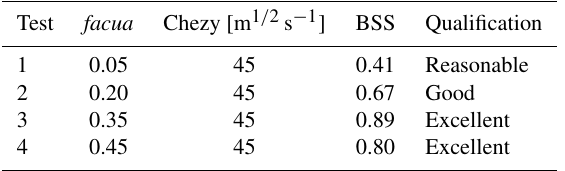
Table 4. XBeach morphodynamic parameters and performance for Bocagrande (Cueto and Otero,